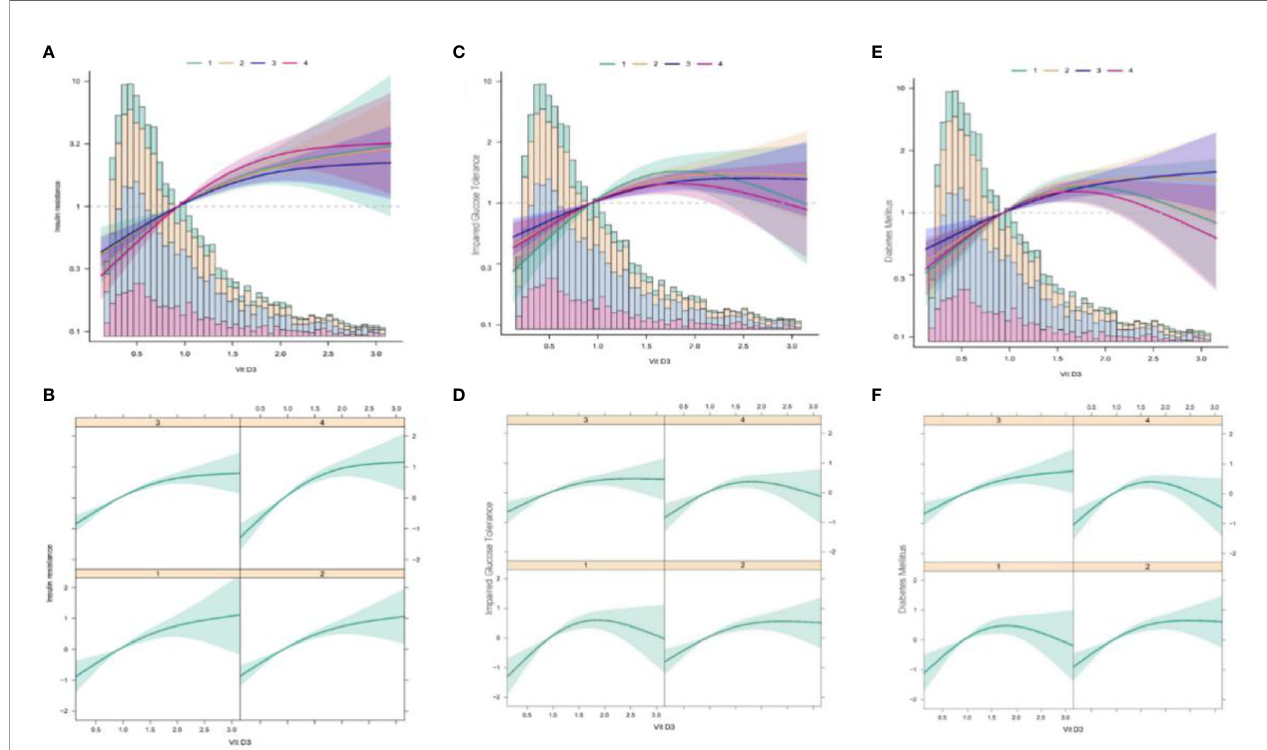
FIGURE 4 | Multivariate logistic regression analysis of the associations of TG/HDL ratio with IR, IGT, and DM in different VD3 groups. TG/HDL, triglycerides/high- density lipoprotein; IR, insulin resistance; IGT, impaired glucose tolerance; DM, diabetes mellitus; VD3, vitamin D3. (A) The association between TG/HDL and IR at different VD3 levels (Total). (B) The association between TG/HDL and IR at different vD3 levels (Separate). (C) The association between TG/HDL and IGT at different VD3 levels (Total). (D) The association between TG/HDL and IGT at different vD3 levels (Separate). (E) The association between TG/HDL and DM at different VD3 levels (Total). (F) The association between TG/HDL and DM at different VD3 levels (Separate). TG/HDL, triglycerides/high-density lipoprotein; IR, insulin resistance; VD3, vitamin D3; IGT, impaired glucose tolerance; DM, diabetes mellitus.